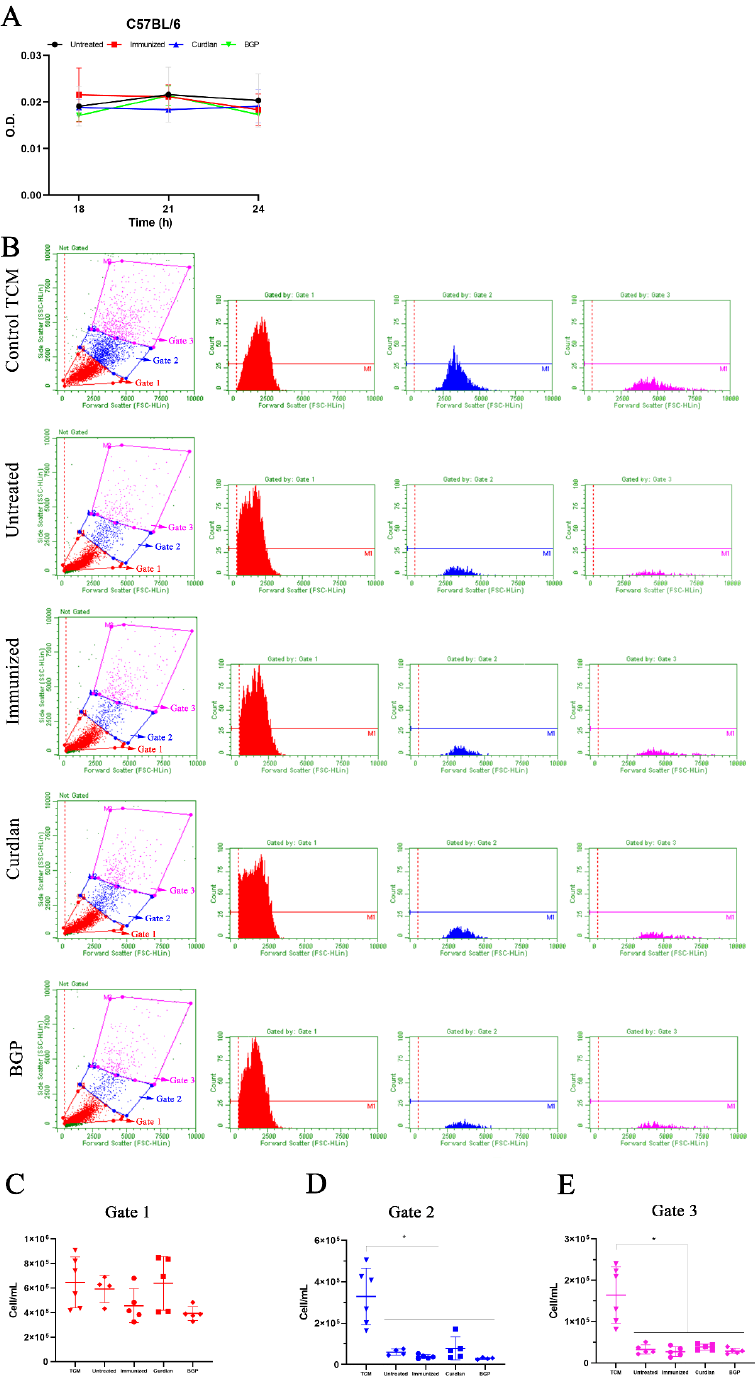
Figure 12. Evaluation of the growth and concentration of C. gattii cells cultured in TCM and incubated with serum from C57BL/6 mice treated with the Dectin-1 ligand. C57BL/6 mice that had received curdlan, BGP, or PBS were immunized with HK- C. gattii -thin before being challenged with C. gattii . Serum was collected after 14 days of infection and incubated with C. gattii in TCM. ( A ) C. gattii R265 was cultured at 37 ◦ C for 18, 21, and 24 h in TCM, and the growth curves were determined in the presence of serum from untreated (black circle), immunized (red square), curdlan (blue triangle), and BGP groups (green triangle). ( B – E ) After 24 h of incubation, C. gattii was analyzed by flow cytometry. The cell size and concentration of the three populations as defined by gates 1 (red; ( B , C )), 2 (blue; ( B , D )), and 3 (pink; ( B , E )) were measured. Cell concentration is expressed in cell/mL. Results are expressed as mean ± SD, or as medians, and maximum and minimum values. * p <